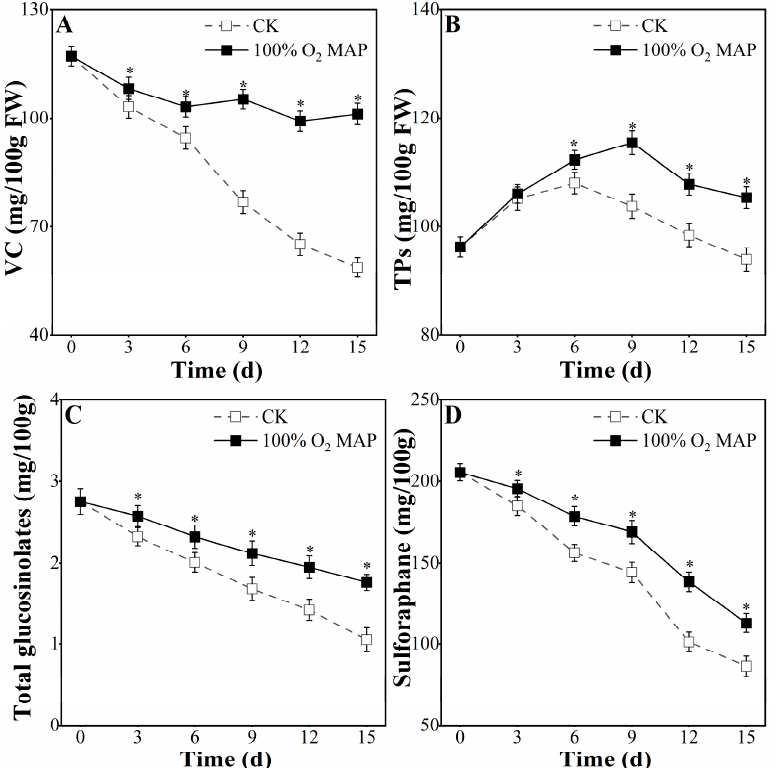
Figure 5. Effect of 100% O 2 MAP on VC, TPs, total glucosinolates, and sulforaphane of fresh-cut broccoli; ( A )—VC (mg/100 g FW); ( B )—TPs (mg/100 g FW); ( C )—Total glucosinolates (mg/100 g); ( D )—Sulforaphane (mg/100 g) of fresh broccoli. * in the figure indicates significant differences among treatments at the same storage time ( p <